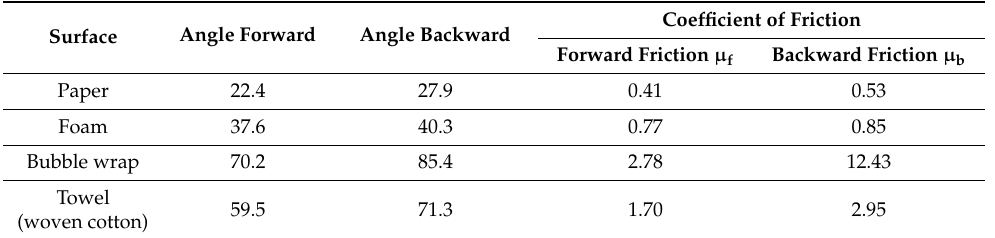
Table 5. Coefficient of friction between the AMDLEM and different frictional